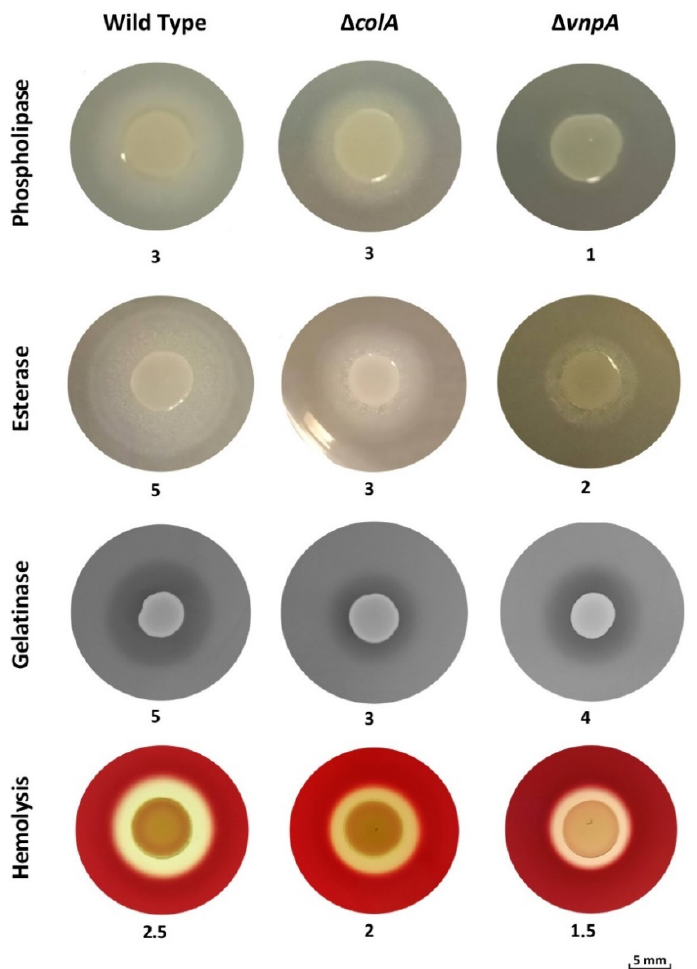
Figure 2. Representative results of phospholipase, esterase, gelatinase and hemolytic activities in the PP-145.98 wild-type strain and in its derivatives vnpA - and colA -defective mutants. Numbers denote halo sizes in millimeters.